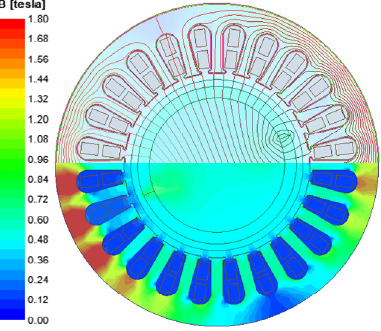
Figure 5. Magnetic flux density and lines distributions of two-pole motor with the stator outer diameter 157